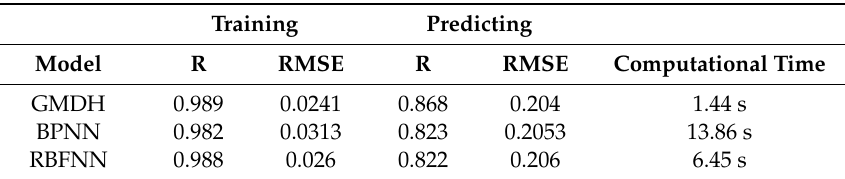
Table 4. Statistical indicators of the developed permeability models.